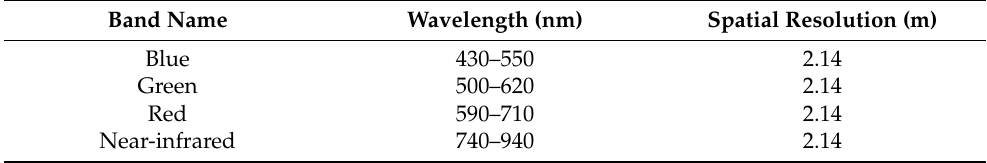
Table 1. Pleiades data from Blad Talh acquired on 16 July